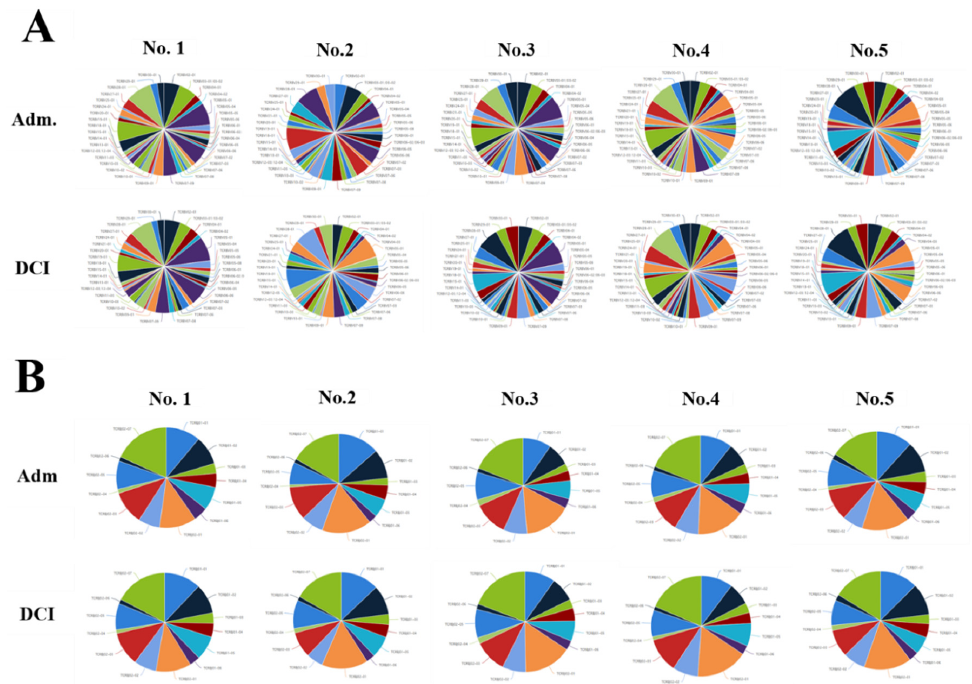
Figure 3. Distribution of the unique clonotypes of TCRBV gene ( A ) and TCRBJ gene ( B ) in patients with subarachnoid hemorrhage between the day of admission and delayed cerebral ischemia (DCI). Different colors represent differences in the gene frequencies of the TCRBV and TCRBJ genes. Compared to the TCRBJ gene segments, the TCRBV gene segments in DCI patients showed different clonotypes in the different time periods.